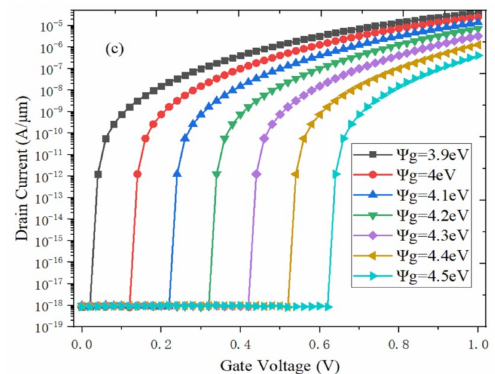
Figure 9. E ff ect of work function ( a ) back gate Ψ bg ; ( b ) drain Ψ d ; ( c ) gate Ψ g on the transfer characteristics of H-DLTFET.